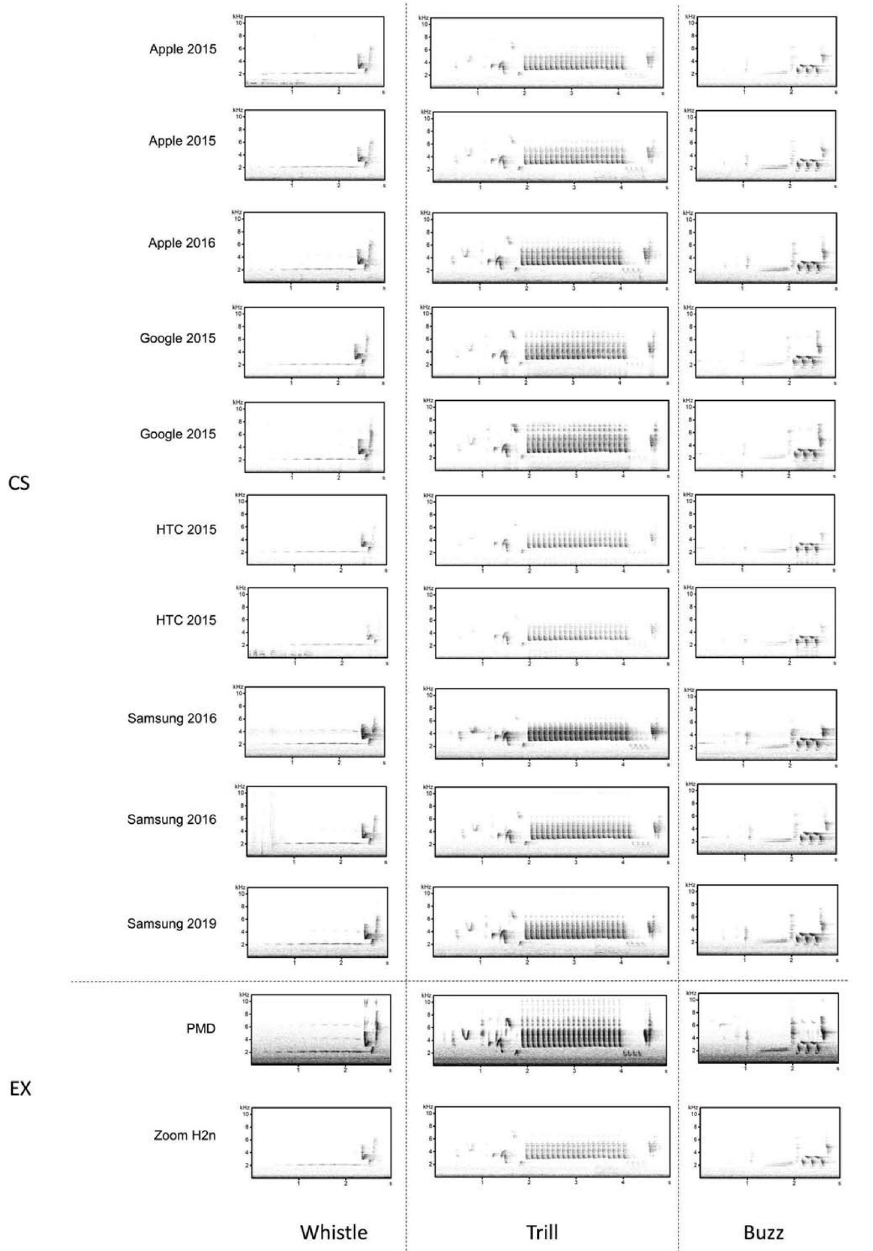
Fig 8. Comparison of citizen science (CS) recordings with the ’Naturblick’ app and expert recordings with equipment using professional microphones (EX) during a playback test. Spectrograms of CS recordings (top) compared to EX recordings (below) for the one example per song categories (whistle, trill and